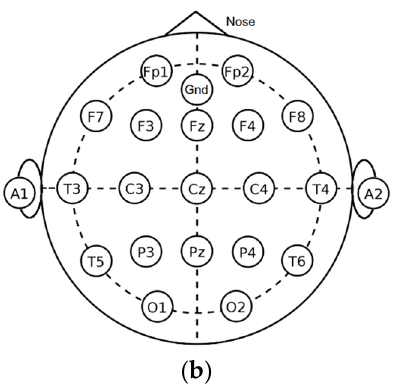
Figure 1. ( a ) Components of the proposed auditory BCI system. ( b ) Electrode placement for 19 channels based on the 10–20 system.